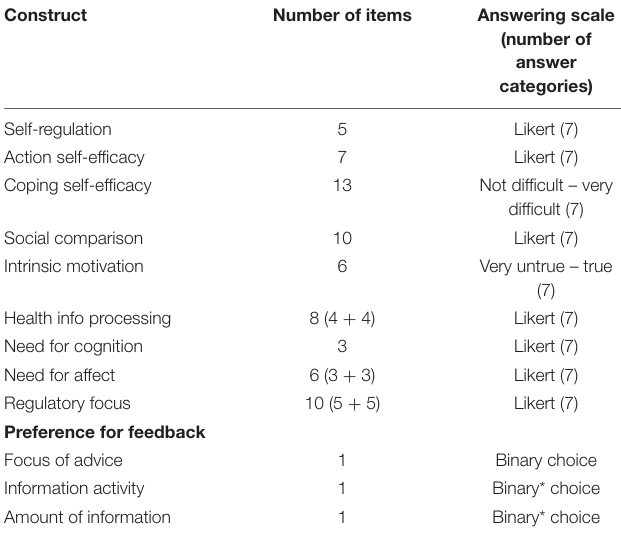
TABLE 1 | Used constructs in the survey, their number of items and the answering scale (and number of answer categories) used (top part); binary questions about the preference for feedback (lower